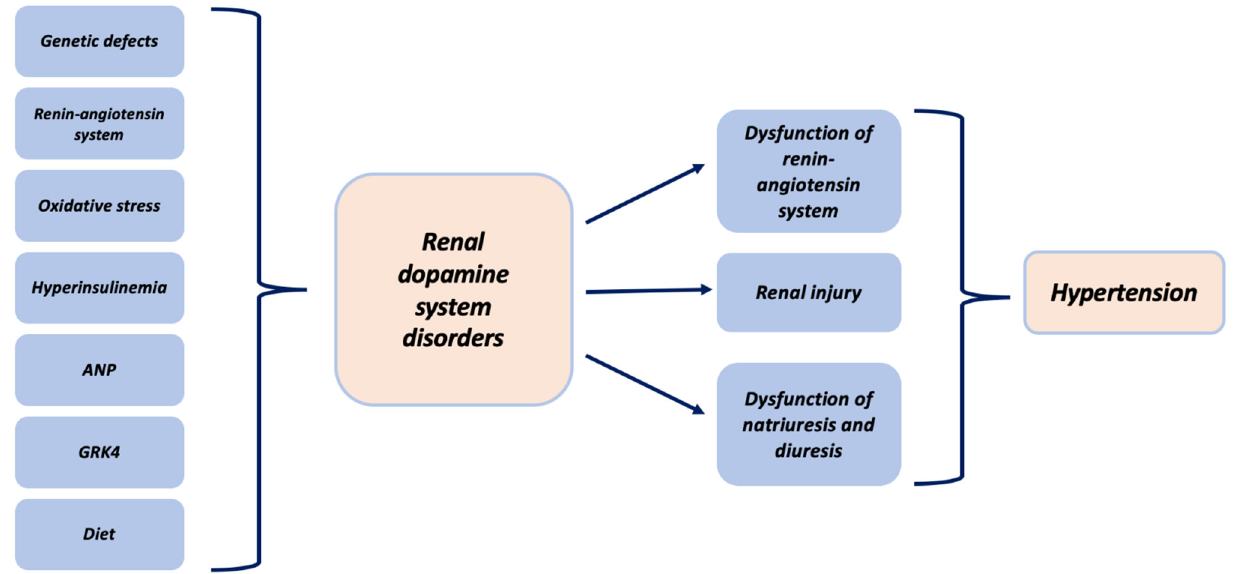
Figure 2. Association between hypertension and the renal dopaminergic